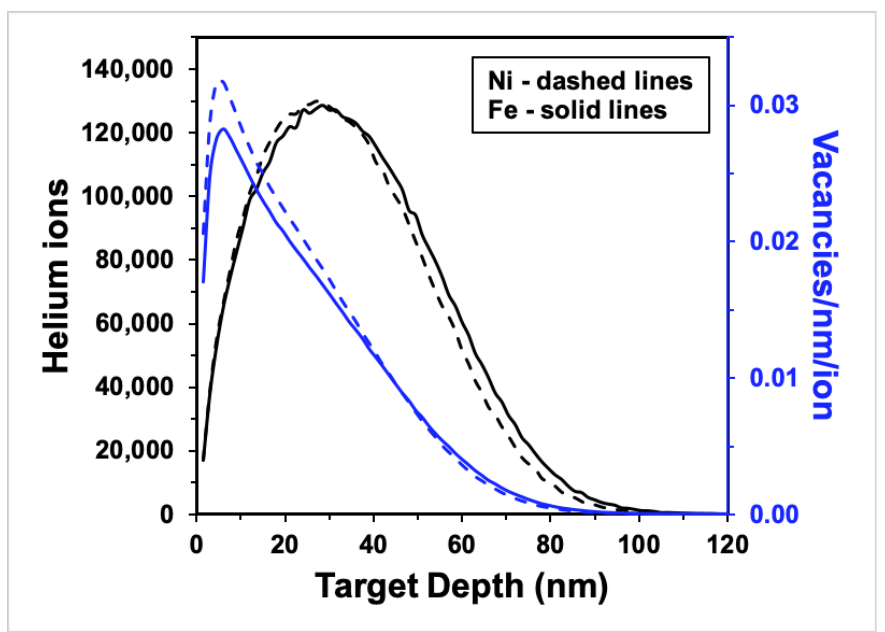
Figure 1. SRIM calculations for 10 keV helium ions bombarding 100 nm-thick Ni (dashed lines) and Fe (solid lines) samples at 60° incidence to the ion beam: ion distribution (black curves) and vacancy production (blue curves) vs. target depth. (For interpretation of the references to color in this figure, the reader is referred to the web version of this article).